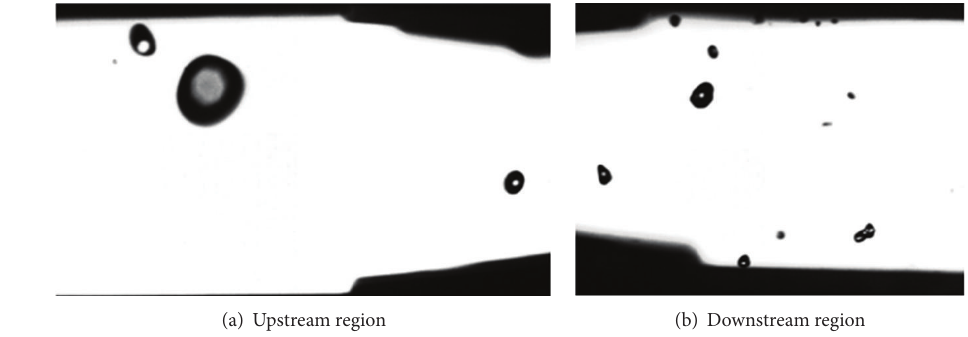
Figure 8: Droplet images near the blockage region.